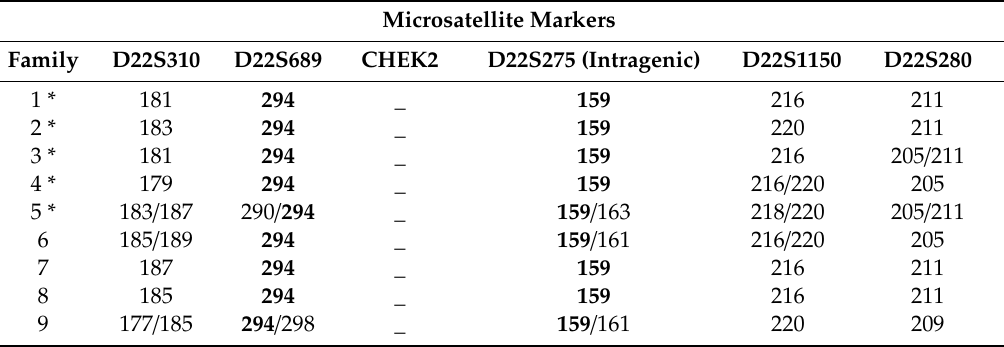
Table 1. Microsatellite marker haplotypes of the 14 families carrying the CHEK2 variant c.349A >